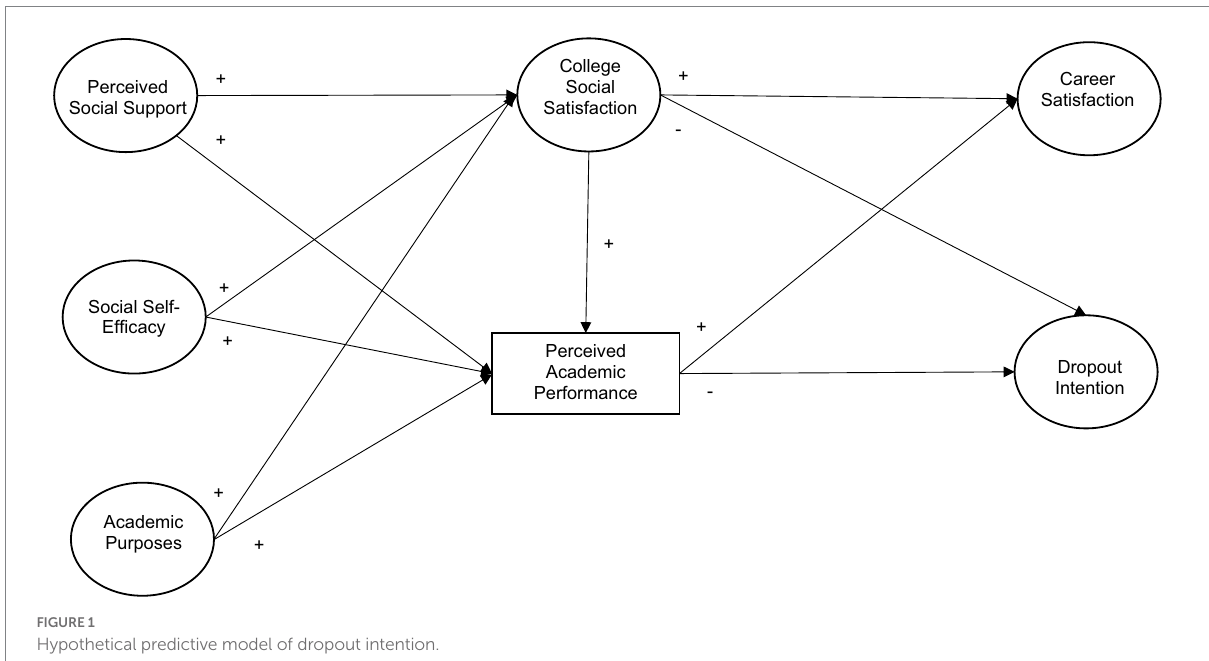
FIGURE 1 Hypothetical predictive model of dropout intention.